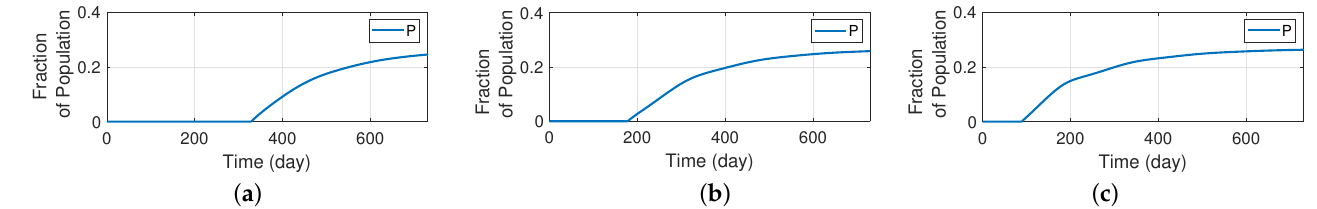
Figure 6. Results of the SIRS model with different levels of severity and vaccination (model depicted in Figure 5); investigating the effect of vaccination initiation on the second and subsequent waves of the pandemic assuming that 0.5% of the susceptible population is daily vaccinated; ( a ) vaccination starts after 11 months of pandemic; ( b ) vaccination begins after 6 months; ( c ) vaccination begins after 3 months. Dashed lines correspond to the model without vaccination, as shown in Figure 4a. The graphs in the last row show the fractional population of the protected individuals.